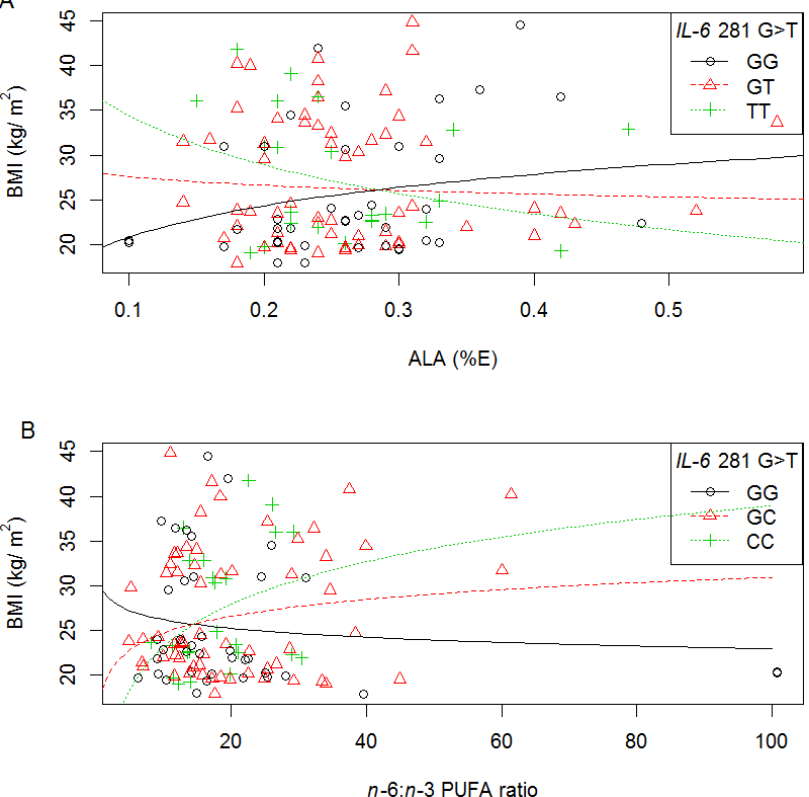
Figure 5. The relationship between BMI, IL-6 IVS3 +281 G>T polymorphism and dietary fat intake in white women. Symbols represent, for each woman, observed values. The lines are modeled relationships for a woman of average age (27.3 years). ( A ) With increasing ALA intake (%E), BMI decreased with each additional IVS3 +281 T allele ( R 2 = 0.16, p = 0.032); ( B ) With increasing n -6: n -3 PUFA ratio, BMI increased with each